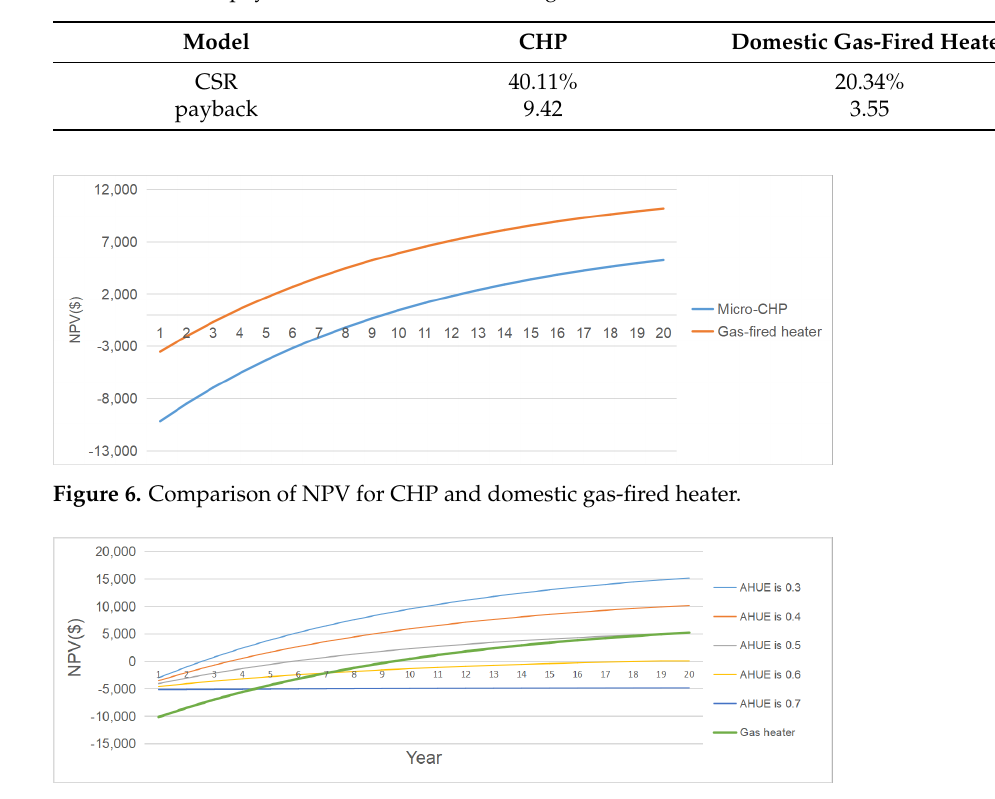
Figure 7. Comparison of NPV of CHP for different